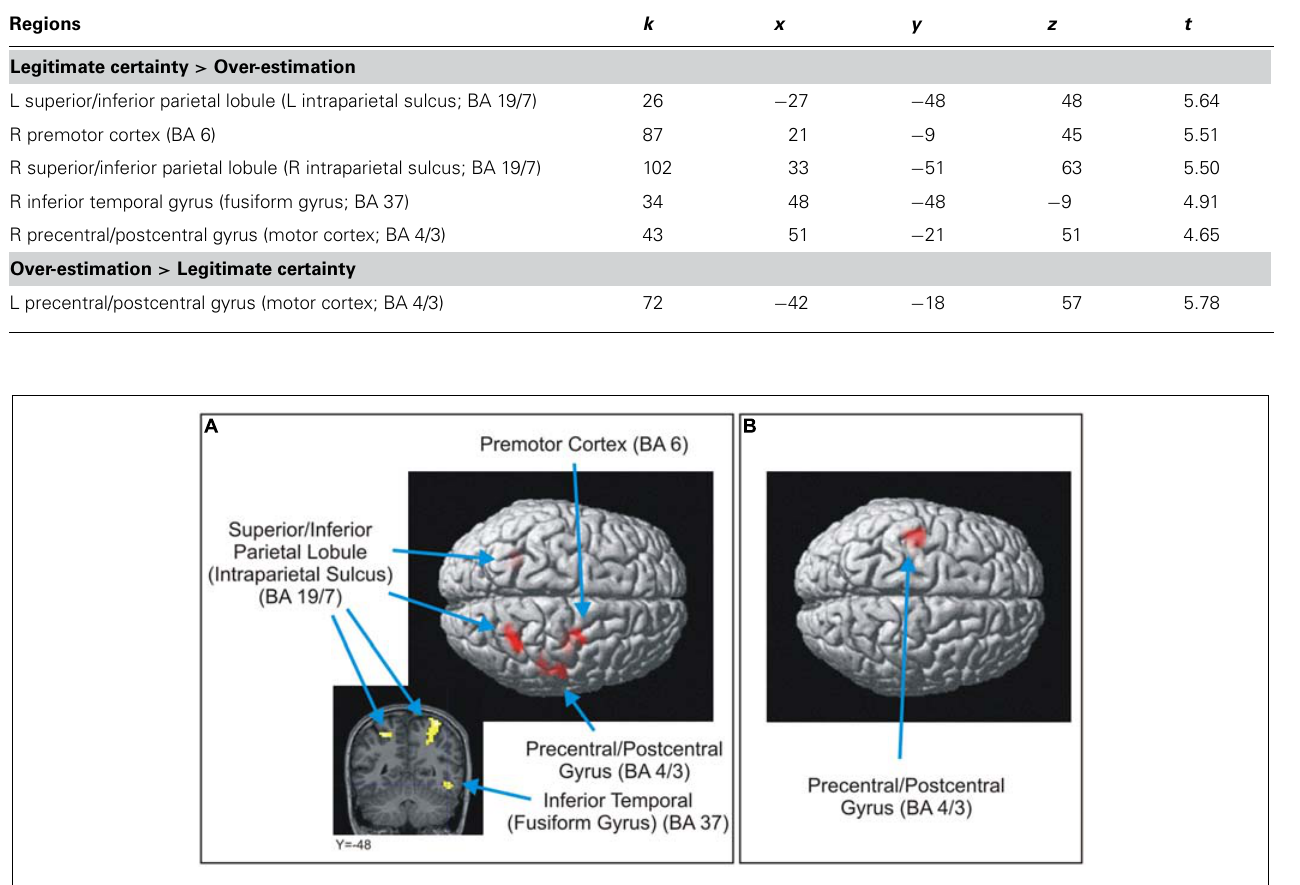
FIGURE 4 | Brain areas significantly more activated in the LC > OE (A) and OE > LC (B) contrasts ( p < 0.0005, uncorrected, min. 20